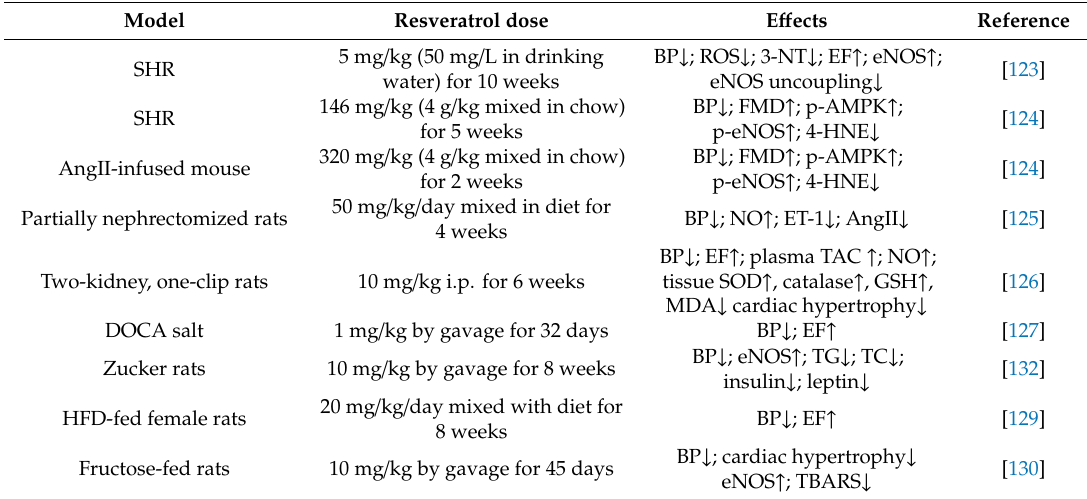
Table 5. Resveratrol reduces blood pressure in animal